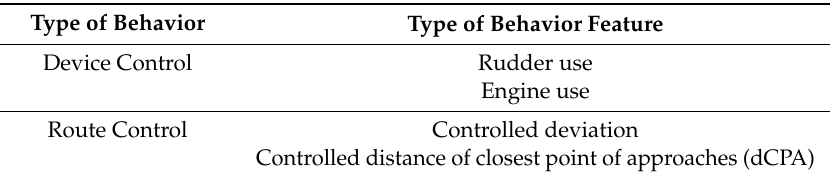
Table 4. Types of behavior and behavior features used in the study.